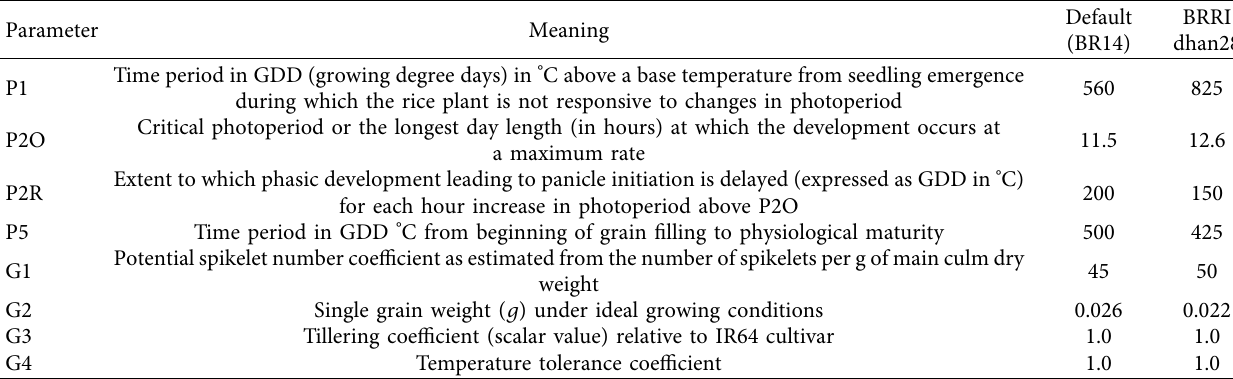
Table 4: Genetic coefficient calibration of BRRI dhan28 for Bangladesh condition.